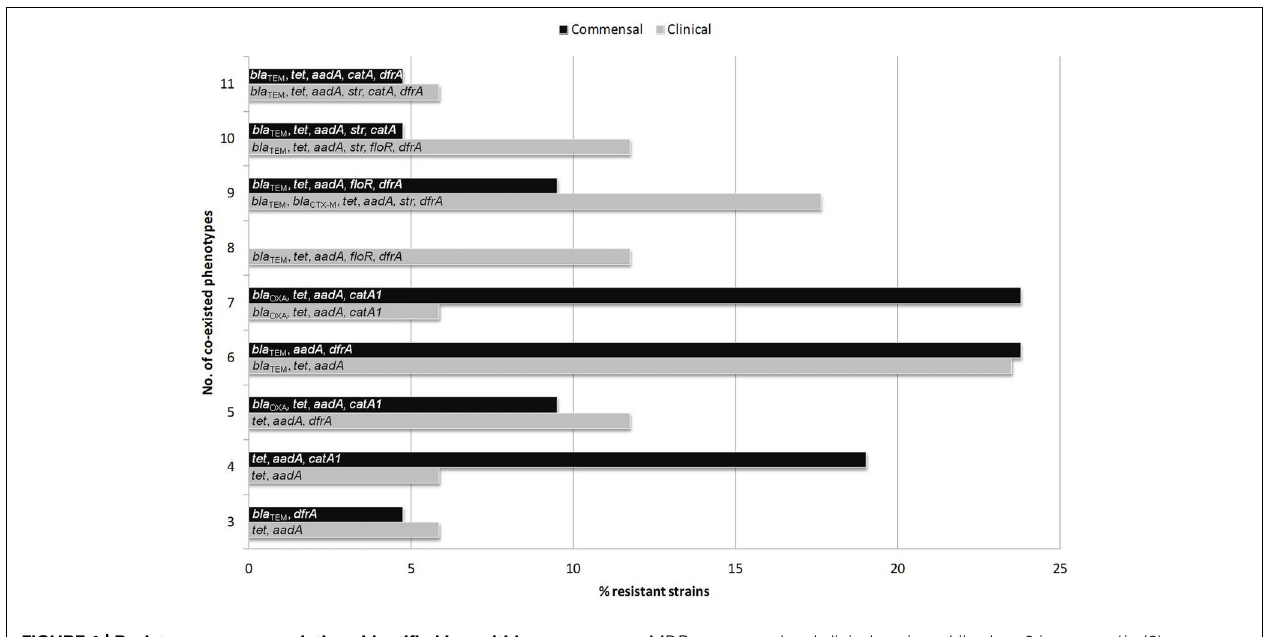
FIGURE 1 | Resistance gene associations identified in multidrug resistant commensal and clinical E. coli strains from food animals, grouped according to increasing numbers of co-existed resistance phenotypes . Class 1 integrons ( intI1) were detected in all groups of